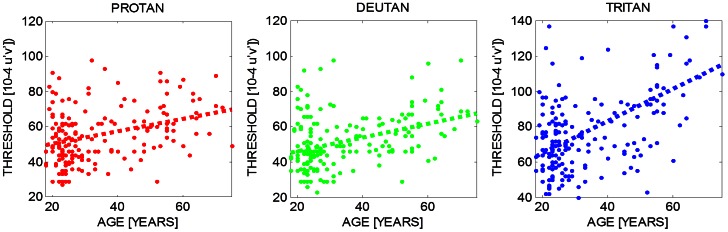
Chromatic sensitivity as a function of age.Thresholds along the protan (left most), deutan (middle) and tritan line (right most) is plotted as function of age for all 185 observers. A linear regression analysis revealed that the slope for all three sets of thresholds differs significantly from zero: Protan: slope = 0.004 R2 = 0.119 p<0.001; Deutan: slope = 0.003 R2 = 0.139 p<0.001; Tritan: slope = 0.254 R2 = 0.258 p<0.001.